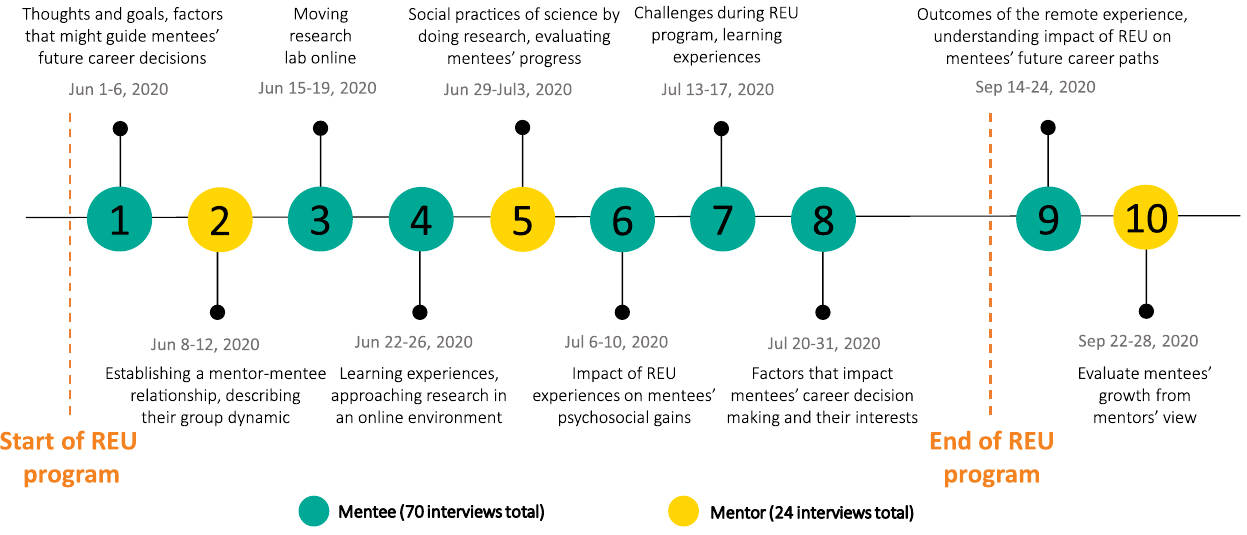
FIG. 1. Overview of interview study design and